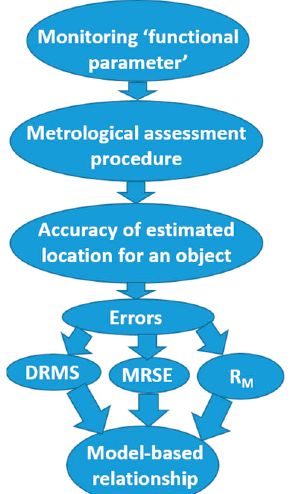
Figure 1. Procedure for sensor reliability assessment using a model-based approach for sensor data and key performance indices.